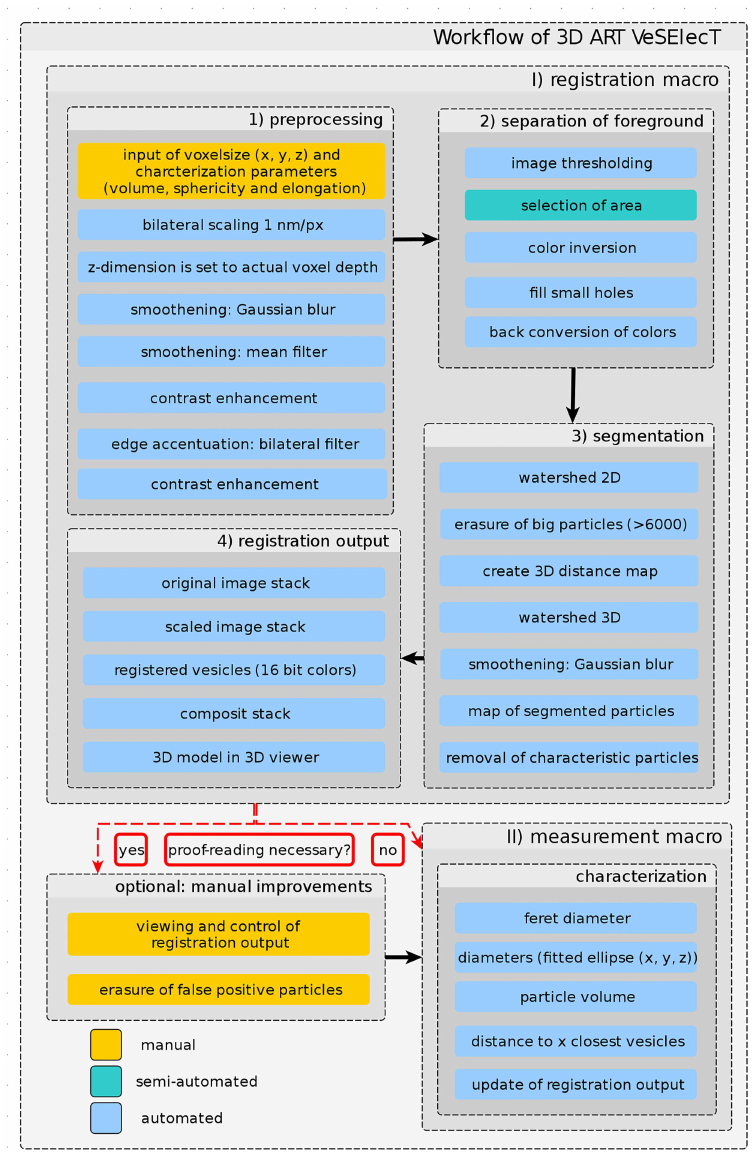
Fig 1. Workflow of vesicle annotation using 3D ART VeSElecT. First, the automatedregistrationmacro is used, which scales the tomogram via user input of the pixel size and appliesvarious filters in the preprocessing step. Afterwards the foregroundis separated, the user semi-automaticallyselects an area of interest, and the macro appliesthe watershed algorithmfor vesicle segmentation and registration. Second, an optional manualproof-reading step can be appliedhere, if necessary.Finally, the automaticmeasurement macro is used to extract results using certain characteristics. All manual steps are colored in yellow, semi- automatedsteps are in turquoise,automatedsteps are in